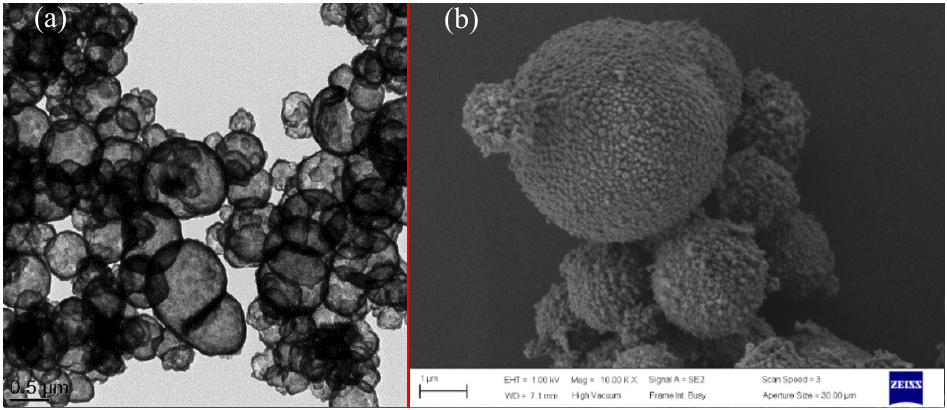
Figure 3. TEM ( a ) and SEM ( b ) micrographs of SiO 2 @IL microcapsules.